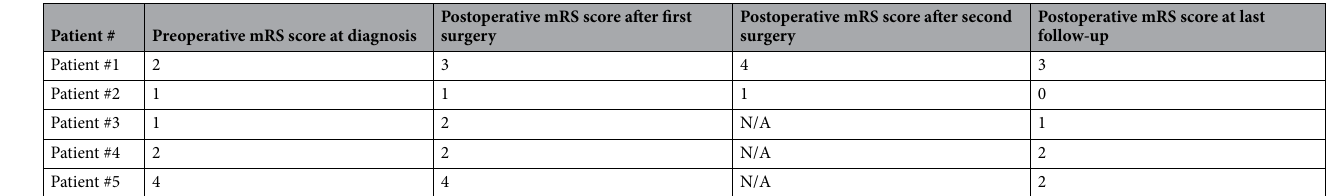
Table 3. Illustration of longitudinal mRS scores at diagnosis, after first and second surgery, and at last follow-up. mRS modified Rankin Scale, N/A not applicable.